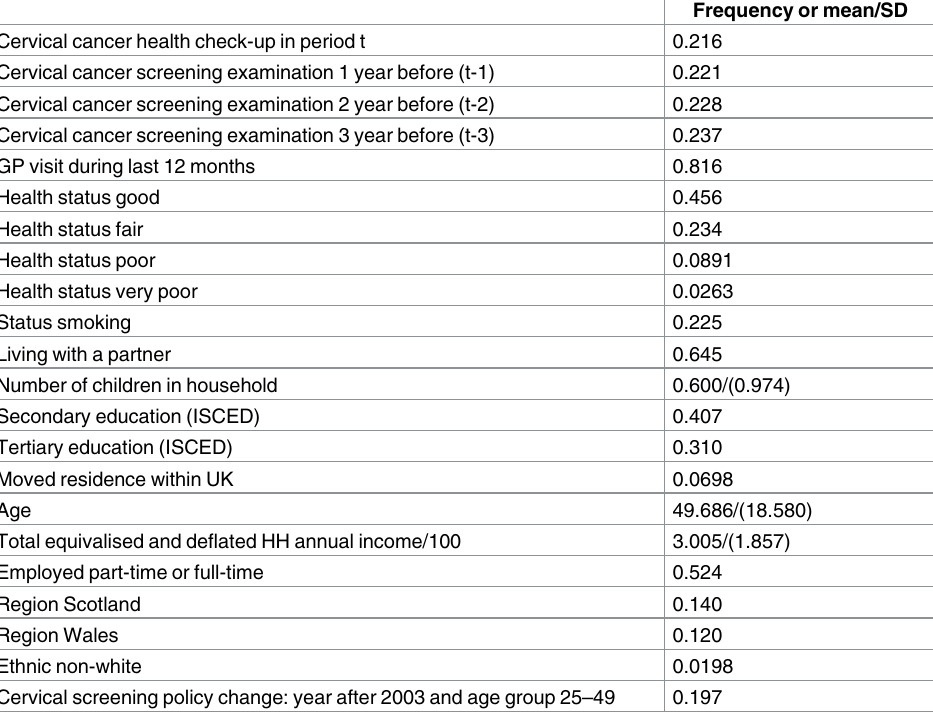
Table 2. Sample characteristics for the balanced sample of women from 1992 to 2008 in Great